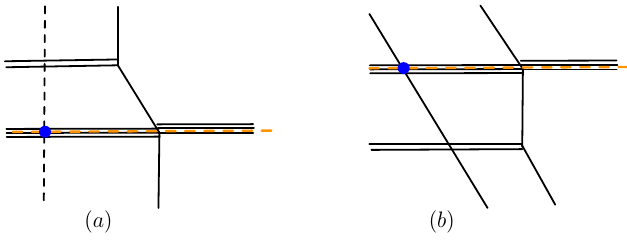
Figure 6 . The original line is denoted by the dashed orange line. In the case ( a ) , we add ( N a − N f ) F above the original line to avoid the intersection, and in the case ( b ) , we add the same number of F below the original line to avoid the intersection. Case ( a ) and case ( b ) are maximal and minimal relative angles respectively for the 3d brane web in figure